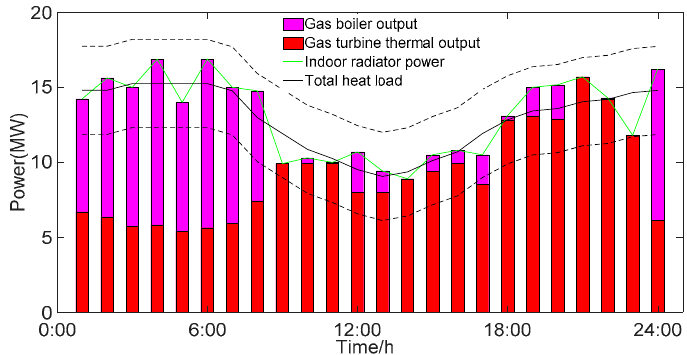
Figure 12. Unit heat output when considering the heat demand envelope.